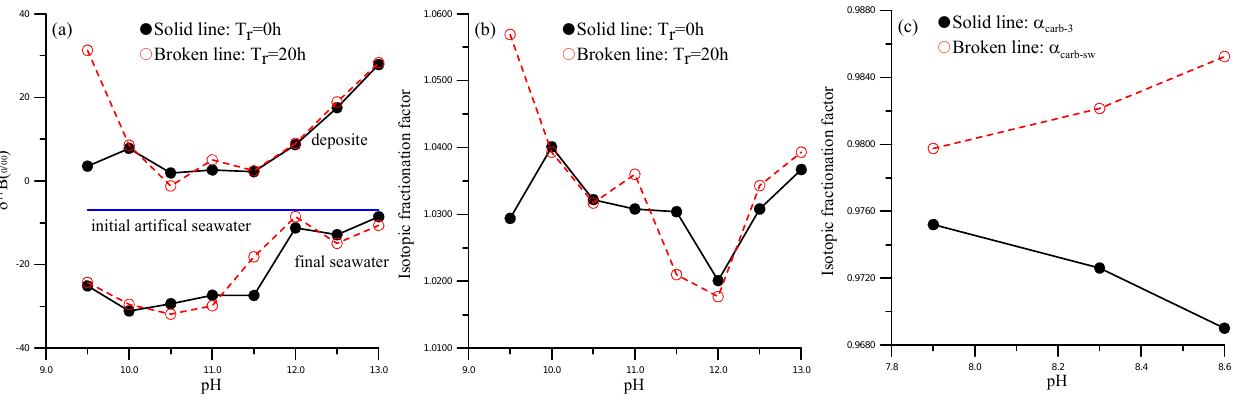
Fig. 3. Isotopic compositions (a) and fractionation factor ( α d-fsw ) (b) of boron between brucite deposit and solution for T r = 0 h and 20 h and (c) between inorganic carbonate and seawater (Sanyal et al., 1996). The variation trend of δ 11 B for T r = 0 h and T r = 20 h are basically same and all the δ 11 B d values are enriched in the heavy isotope relative to the δ 11 B fsw (Fig. 3a). All the α d-fsw are greater than 1 and shows a waved pattern (Fig. 3b), which is entirely different from that of the carbonates deposits (Fig. 3c).